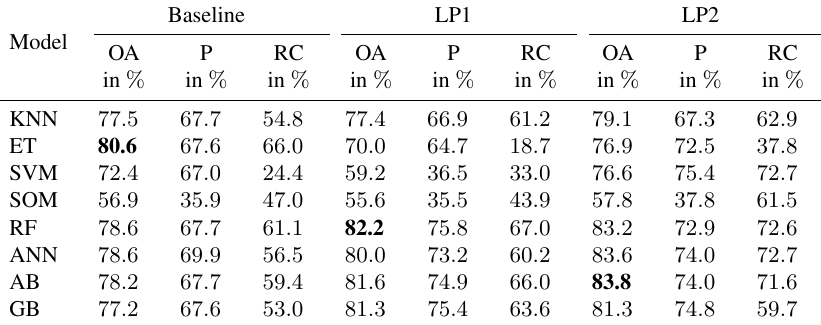
Table 4. Overview of the results of event vs. no event classification for the ML models under consideration. The classification performance is expressed by the overall accuracy (OA), precision (P) and recall (RC). The highlighted figures represent the best classification results for each preprocessing approach.